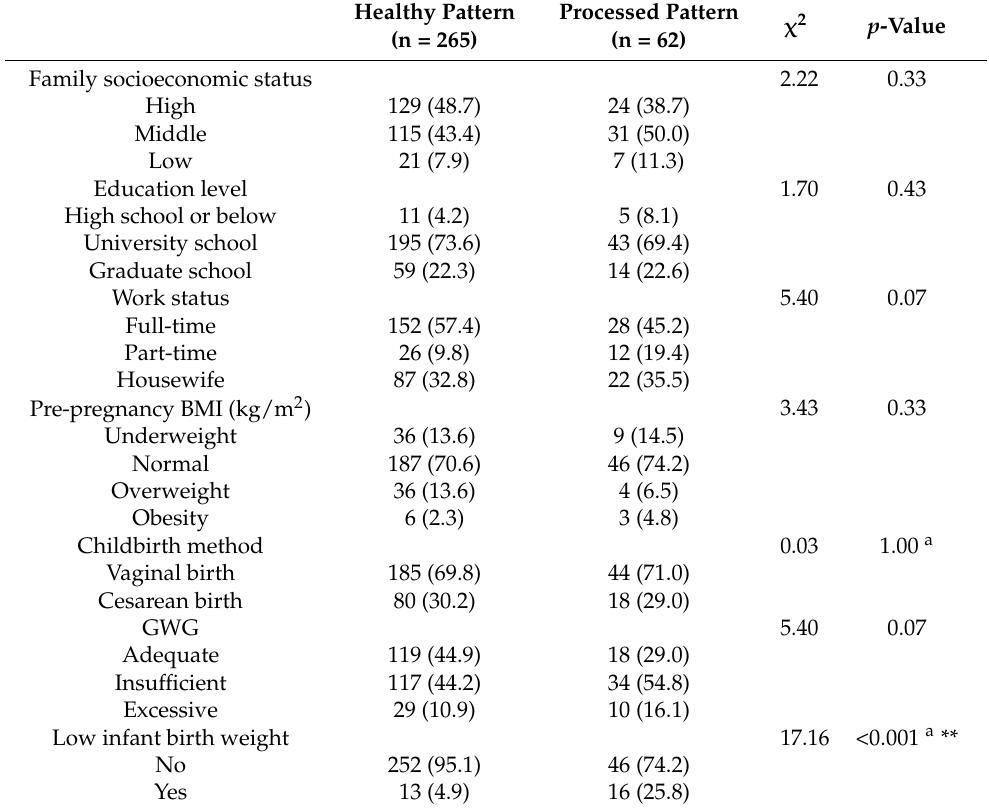
Table 3. Dietary pattern of maternal characteristics (N =